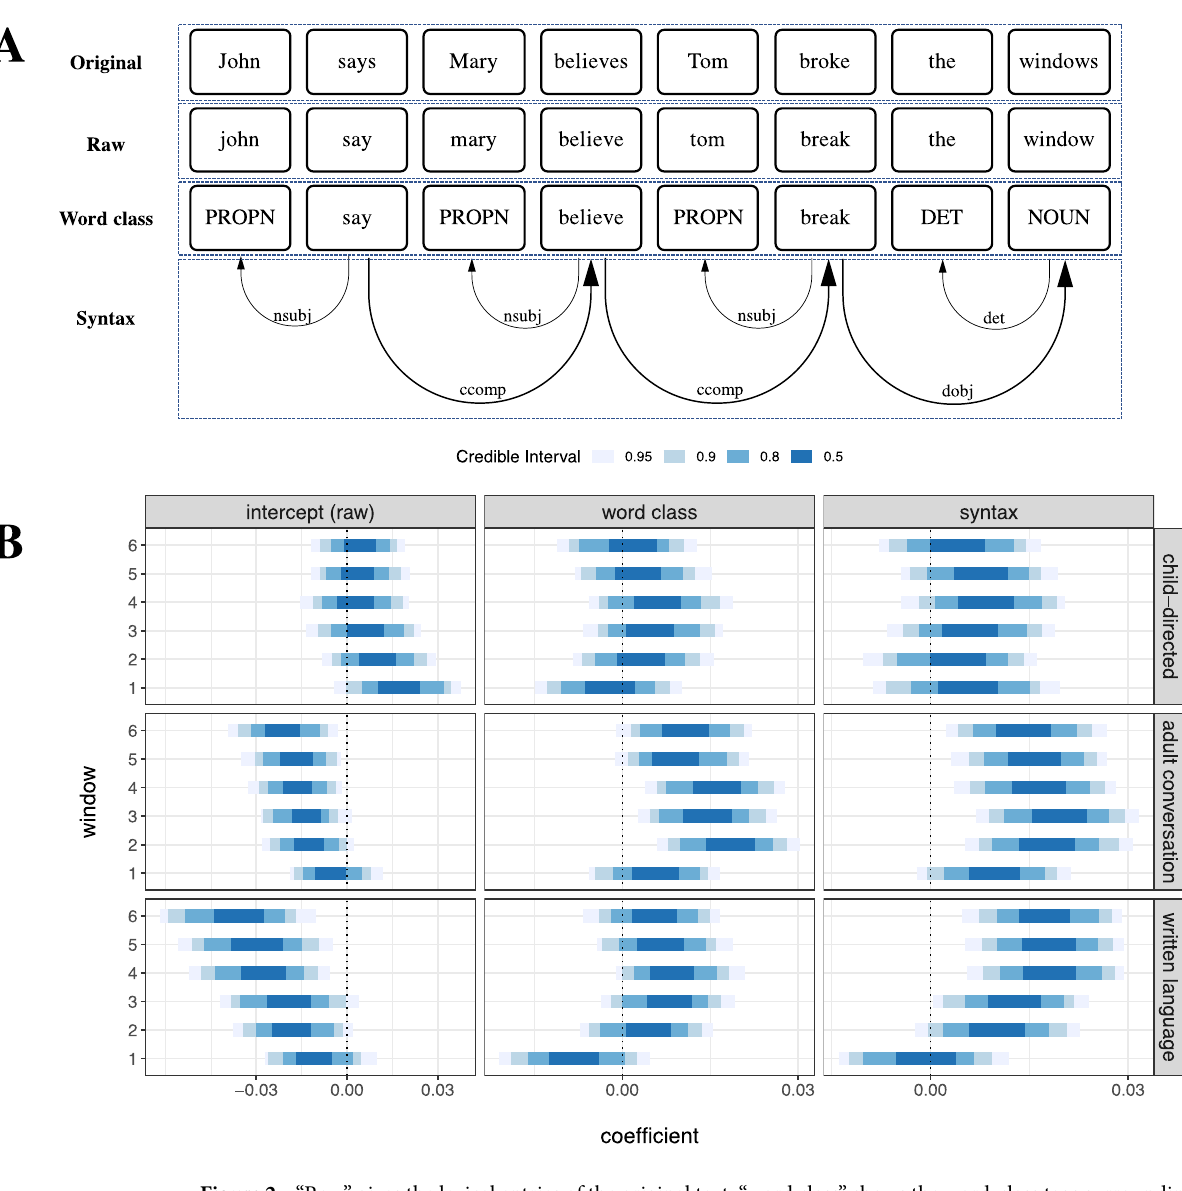
Figure 2. “Raw” gives the lexical entries of the original text, “word class” shows the word-class tags surrounding the verbs, and “syntax” denotes the dependencies that the verbs open (in the CLEAR style 90 as tagged by spaCy). The dependencies are represented by arrows with the relation tags on top. The training data for each layer (word class vs. syntax) consists of both the raw utterances and the information from the respective layer ( A ). Discrimination of causative meanings remains stable or deteriorates when further syntactic information is made available in child-directed speech, but mostly improves when such information is made available in adult conversation and written language ( B ). Credible intervals represent highest posterior